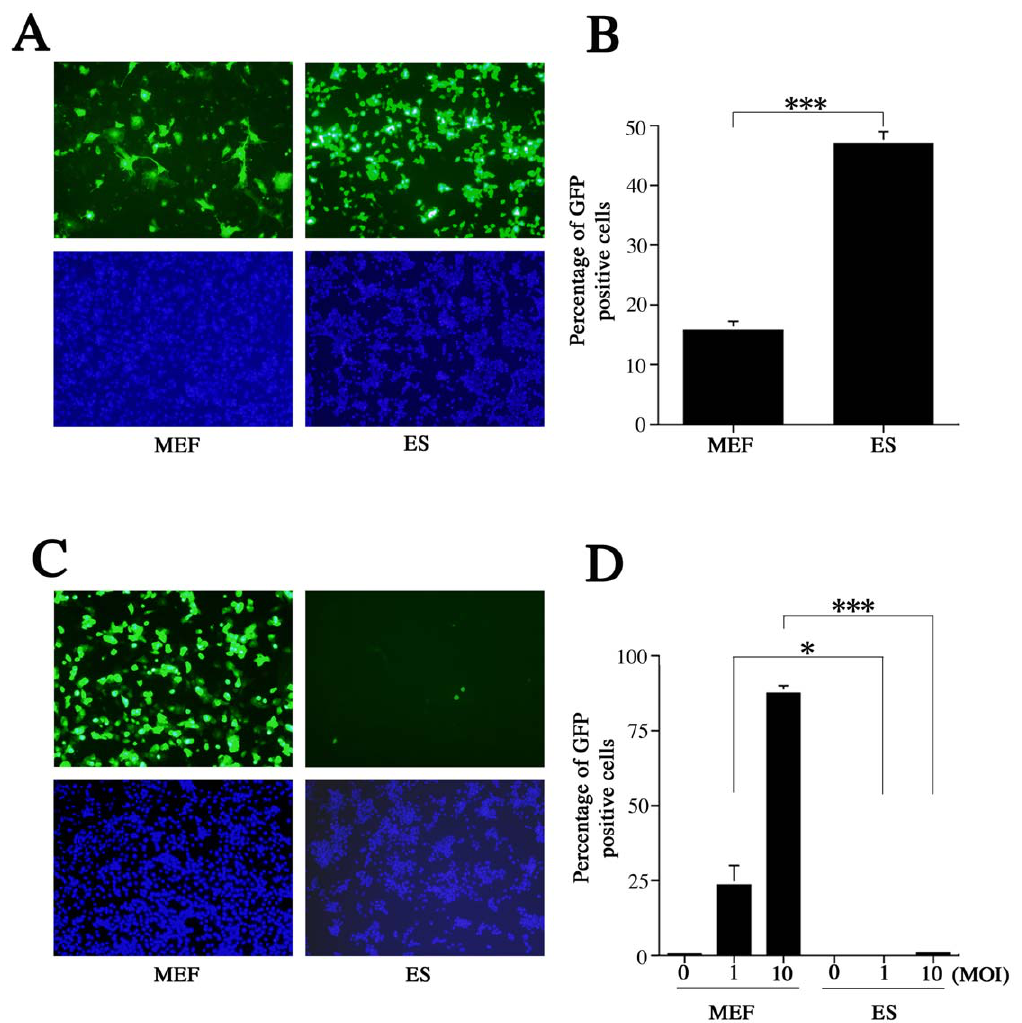
Figure 5. Effects of the elongation factor-1 a promoter in ES cells infected with recombinant MCMV. (A) GFP-positive cells in ES and MEF cultures after transfection via electroporation (green: GFP; blue: DAPI) at 24 hours post-transfection. (B) ES cultures had nearly 3 times as many GFP- positive cells (46.9%) as MEF cultures (15.8%) at 24 hours post-transfection ( P , 0.001). (C) Recombinant MCMV was constructed to express an EGFP gene insert under control of EF-1 a promoter. GFP positive cells were barely detectable in ES cells at 24 hpi after infection at an MOI of 10 (green: GFP, blue: DAPI). (D) The proportion of GFP-positive cells was significantly higher in MEFs than in ES cells infected at MOIs of 1 ( P , 0.05) and 10 ( P , 0.001). All presented experiments were performed at least 3 times, and data are given as the mean 6 SD. * P , 0.05, ** P , 0.01, *** P , 0.001, t- test.